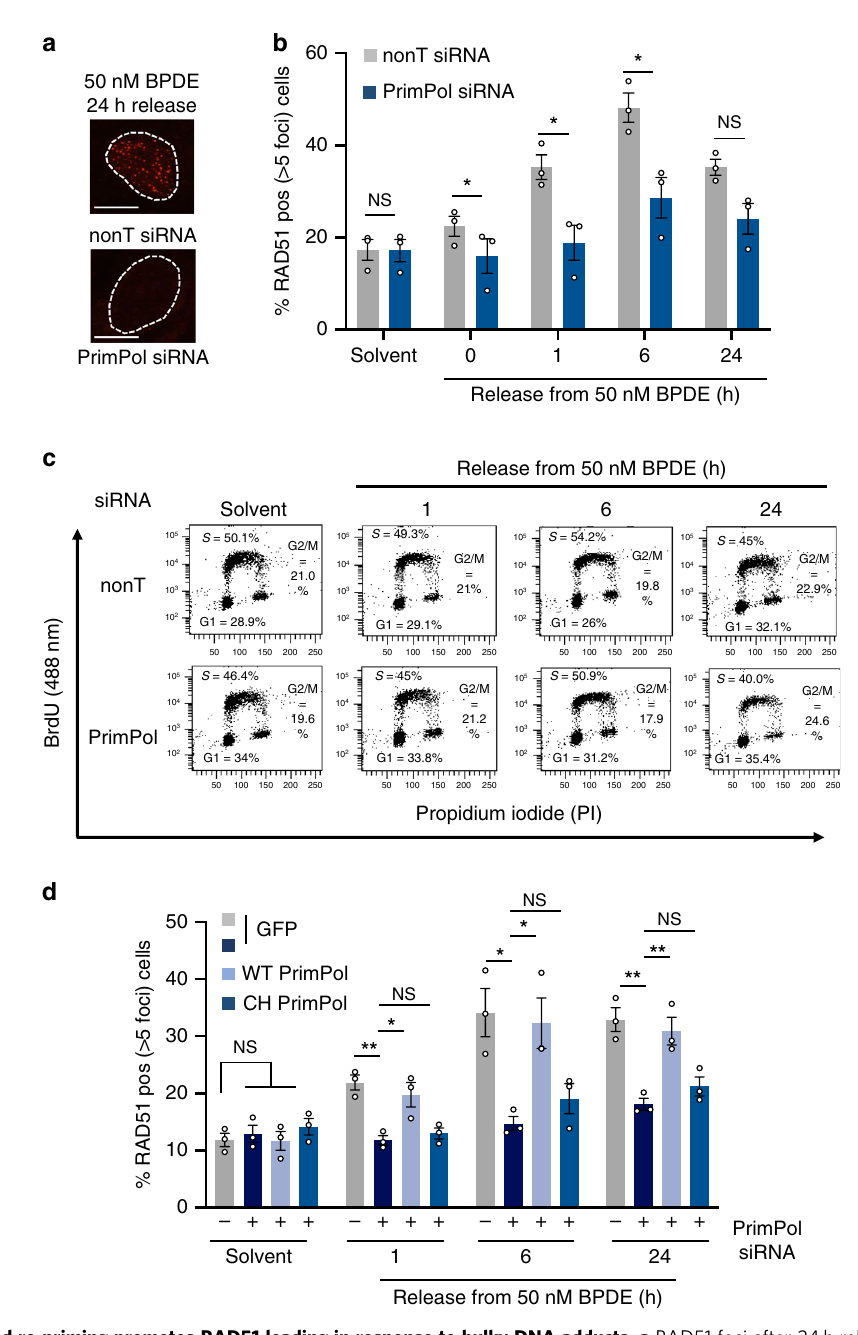
Fig. 3 PrimPol-mediated re-priming promotes RAD51 loading in response to bulky DNA adducts. a RAD51 foci after 24 h release from 50 nM BPDE in the presence of nonT or PrimPol siRNA. Images are representative of n = 3. Scale bars: 10 μ m. b Percentages of U2OS cells with >5 RAD51 foci after release from 50 nM BPDE, in presence of nonT or PrimPol siRNA. n = 3. c Representative cell cycle distributions after release from solvent (1 h) or 50 nM BPDE in presence of nonT or PrimPol siRNA. Cells were incubated with BrdU for 30 min to label replicating cells prior to fl ow cytometry. Percentages are means from three independent experiments as shown in Figure S4A. d Percentages of cells with >5 RAD51 foci after release from 50 nM BPDE, with or without PrimPol shRNA depletion and expression constructs encoding GFP or WT or CH PrimPol. The release from the solvent was 1 h. n = 3. Source data are provided as a Source Data fi le. The means and SEM (bars) of at least three independent experiments are shown. Asterisks indicate p -values (one-sided student ’ s t-test for B or one-way ANOVA for D, * p < 0.05, ** p <